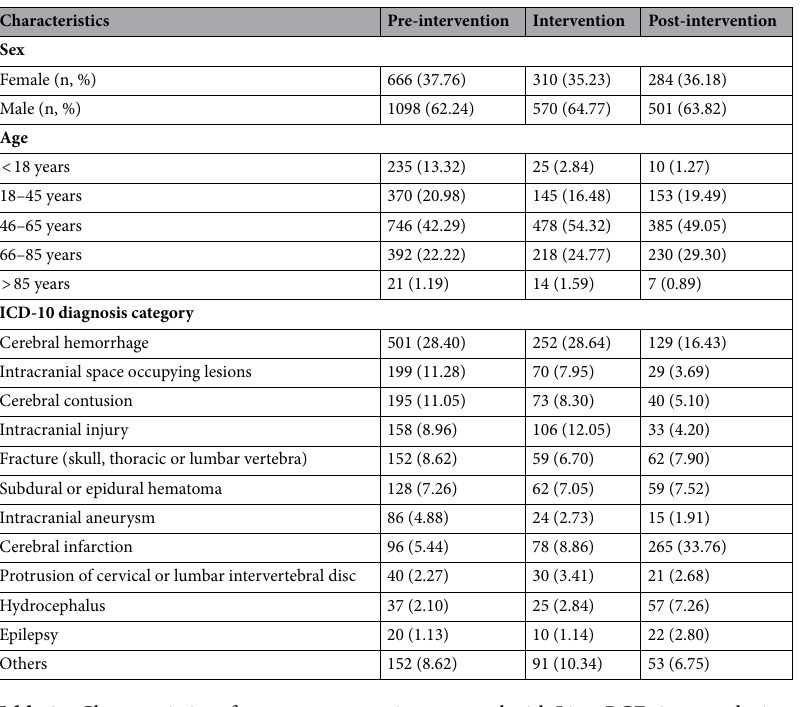
Table 3. Characteristics of neurosurgery patients treated with Lipo-PGE 1 in pre-, during, and post- intervention